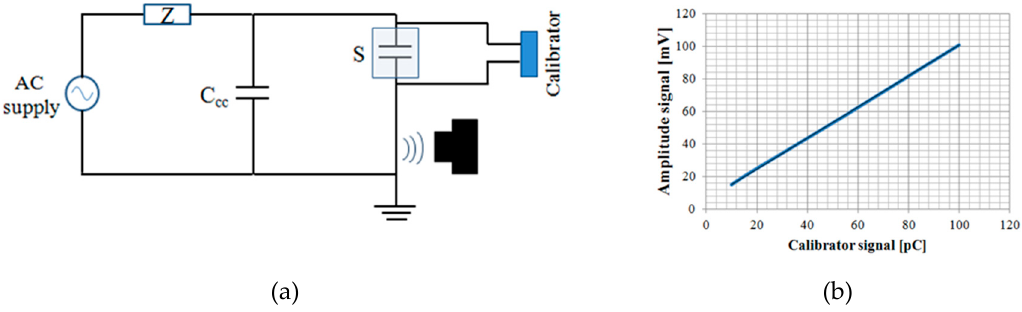
Figure 8. Measurements with the calibrator at different amplitudes of the signal: ( a ) The measurement circuit; ( b ) results.